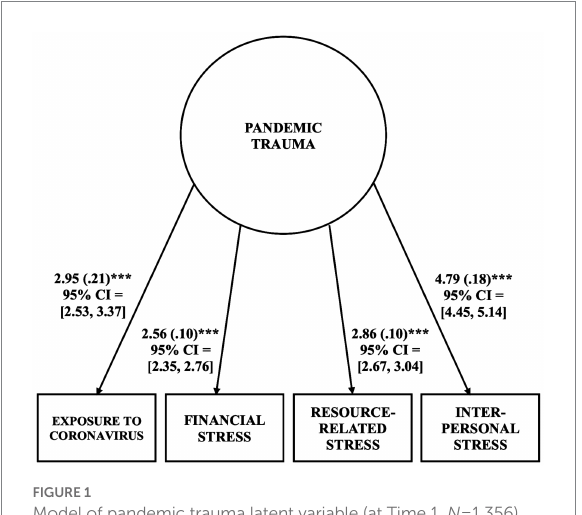
FIGURE 1 Model of pandemic trauma latent variable (at Time 1, N = 1,356). Unstandardized estimates are shown with standard errors in parentheses and with the 95% bias-corrected CI in brackets. The latent variable accounted for 27.90%, 38.10%, 51.40%, and 49.70% of the variable in the exposure to coronavirus, financial stress, resource-related stress, and interpersonal stress indicators, respectively. All p ’s <